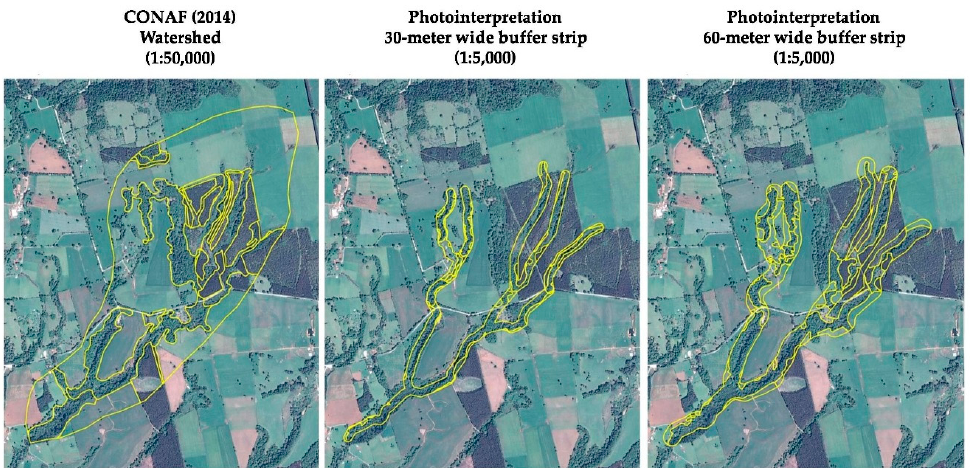
Figure 2. Example of the mapping and assessment of land use/land cover classes in the entire watershed and 30 and 60-meter wide buffer strip with through the photointerpretation of color satellite imagery viewed in ©2015 Google Maps [38]; buffers were delimited with QGIS [40]. Streamside native forests were expressed as the percentage of native forest (NF) cover found in 30 and 60-meter wide buffer strips, which ranged from 32% to 78% and 18% to 80% in watersheds dominated by forest plantations (WFP, Figure 3a) and agricultural lands (WAL, Figure 3b), respectively.